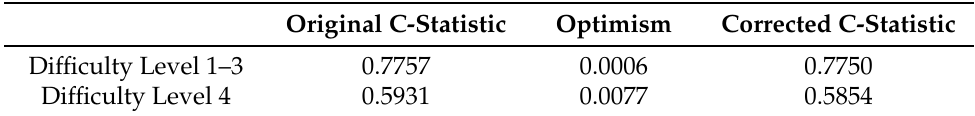
Table 10. Bootstrap-validated C-statistic for the multivariate logistic regression models shown in Tables 8 and